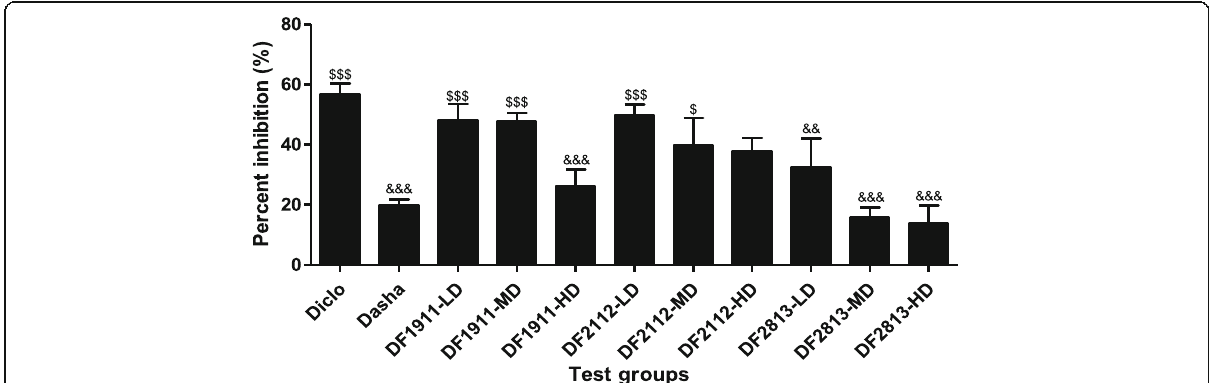
Fig. 1 Percentage inhibition of paw edema. Diclo: Diclofenac sodium, Dasha: Dashamoola Kwatha , DF: Dashamoola Formulation, LD: Lower dose, MD: Middle dose, HD: Higher dose. Values are expressed as Mean ± SEM; n = 6. Data were analysed by One-Way ANOVA followed by Dunnett ’ s multiple comparison test. && = p < 0.01, &&& = p < 0.001 when compared to Diclo; $$$ = p < 0.001 when compared to Dasha